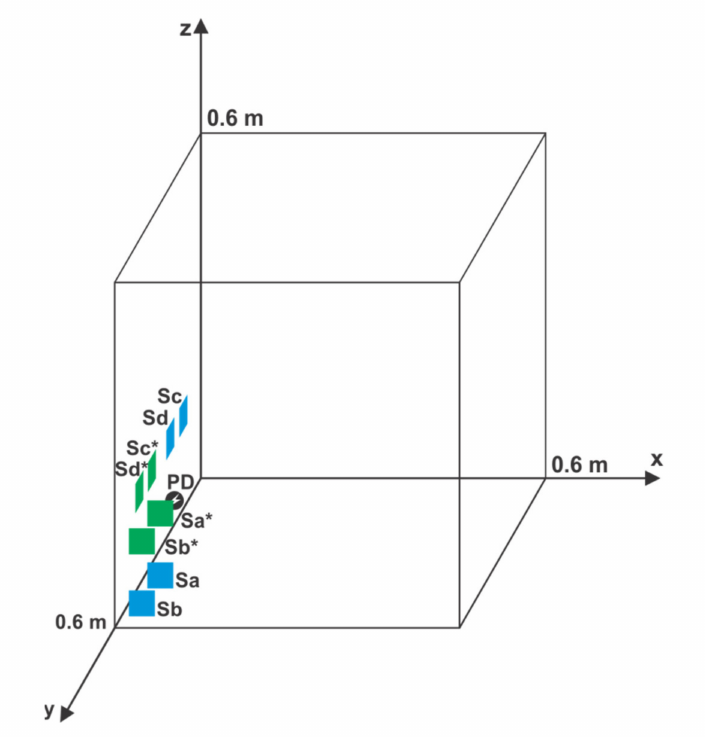
Figure 8. Nominal position of PD, starting position of sensors (S a , S b , S c , and S d ), and optimal position of sensors (S a *, S b *, S c *, and S d *), in the second